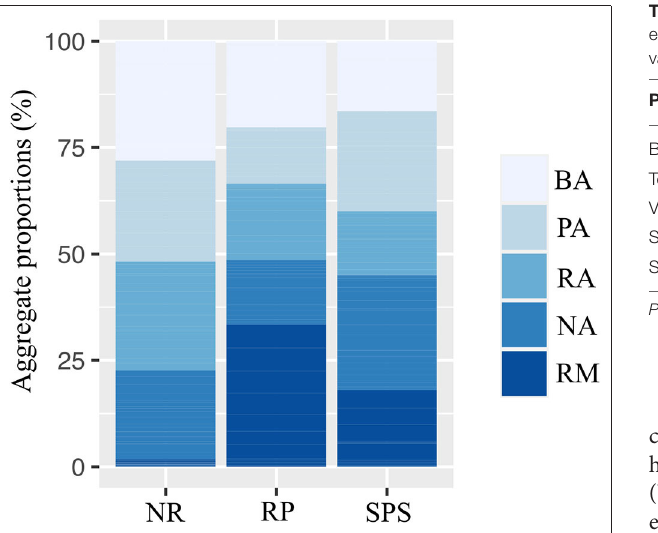
FIGURE 5 | Proportions of land aggregates classified according to their origin in Natural Regeneration (RN), silvopastoral systems (SPS), and rubber plantations (RP) in Colombian Amazon region. BA, biogenic aggregates; NA, soil not macro-aggregate; PA, physical aggregates; RA, root aggregates; RM, remaining material.